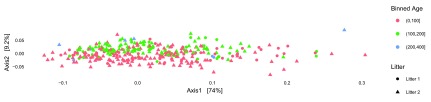
A DPCoA plot incorporates phylogenetic information, but is dominated by the first axis.